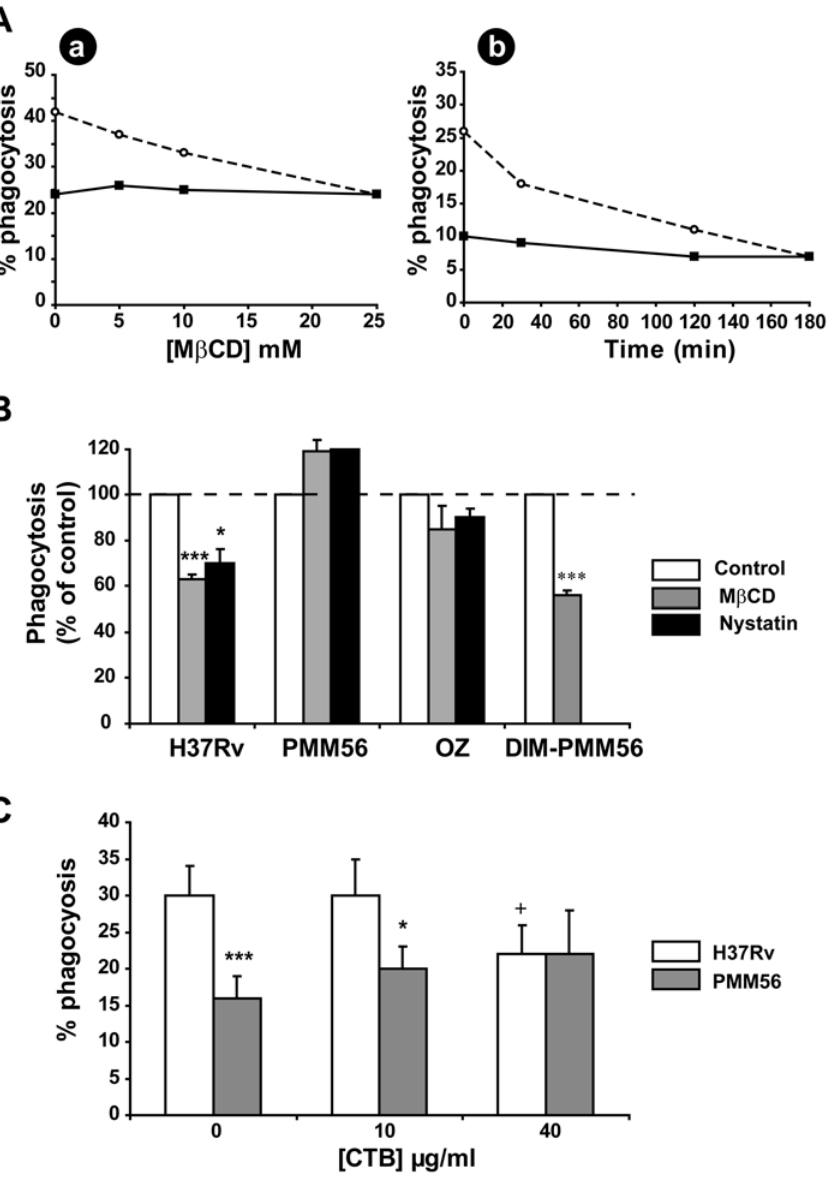
Figure 4. The DIM-dependent phagocytosis of Mtb required plasma membrane cholesterol. (A) MDMs were initially incubated at 37 u C with (a) various concentrations of M b CD for 30 minutes or (b) 10 mM M b CD for various periods of time. They were then washed and infected for 60 minutes with H37Rv WT (white circle) or the PMM56 mutant at an MOI of 10 (black square); one experiment representative of three separate experiments. (B) MDMs left untreated or treated with 10 mM M b CD or 20 m g/ml Nystatin for 30 minutes were infected with H37Rv WT or the PMM56 mutant or the DIM-coated PMM56 mutant at an MOI of 10 for 60 minutes or incubated with the serum-opsonized zymosan (OZ) at an MOI of 25 for 45 minutes. The data are expressed as a percentage phagocytosis with respect to untreated conditions (control; 100%). The values presented are means 6 SEM for three to four separate experiments. We evaluated the significance between cell subjected to drug pretreatment and untreated cells: *, p , 0.05; ***, p , 0.01. (C) MDMs were left untreated or treated with various concentrations of CTB for 30 minutes. They were washed and infected for 60 minutes with H37Rv WT or the PMM56 mutant at an MOI of 10. The data are presented as the percentage of phagocytosis. The values are means 6 SEM for three separate experiments. The significance of the drug effect was assessed by comparing data under treated and untreated conditions: + , p , 0.05; the significance of the effect of DIM deficiency was assessed by comparing data for mutants and the WT strain.*, p , 0.05, ***p ,